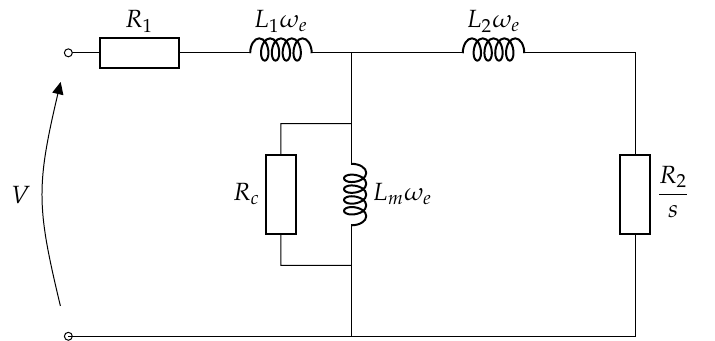
Figure 1. Squirrel-cage induction motor model in steady